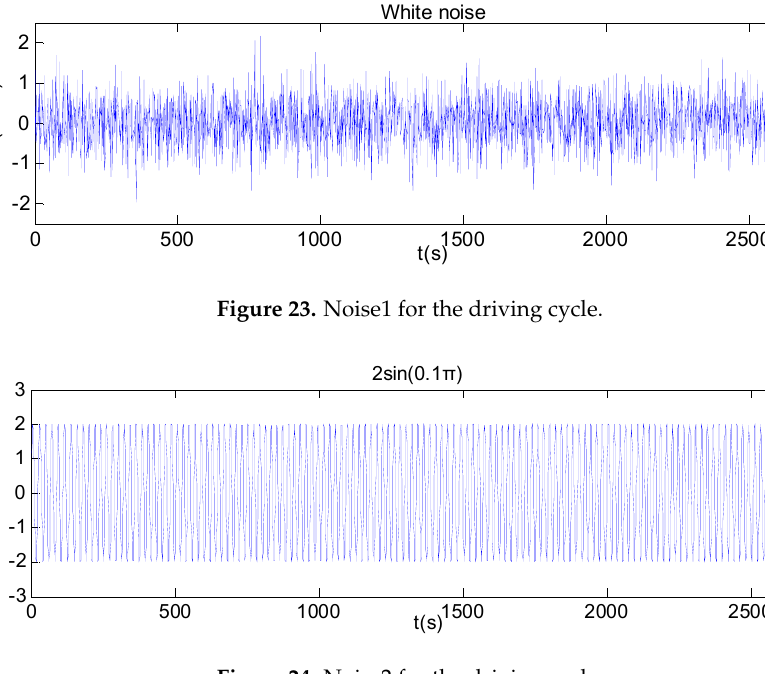
Figure 24. Noise2 for the driving cycle.